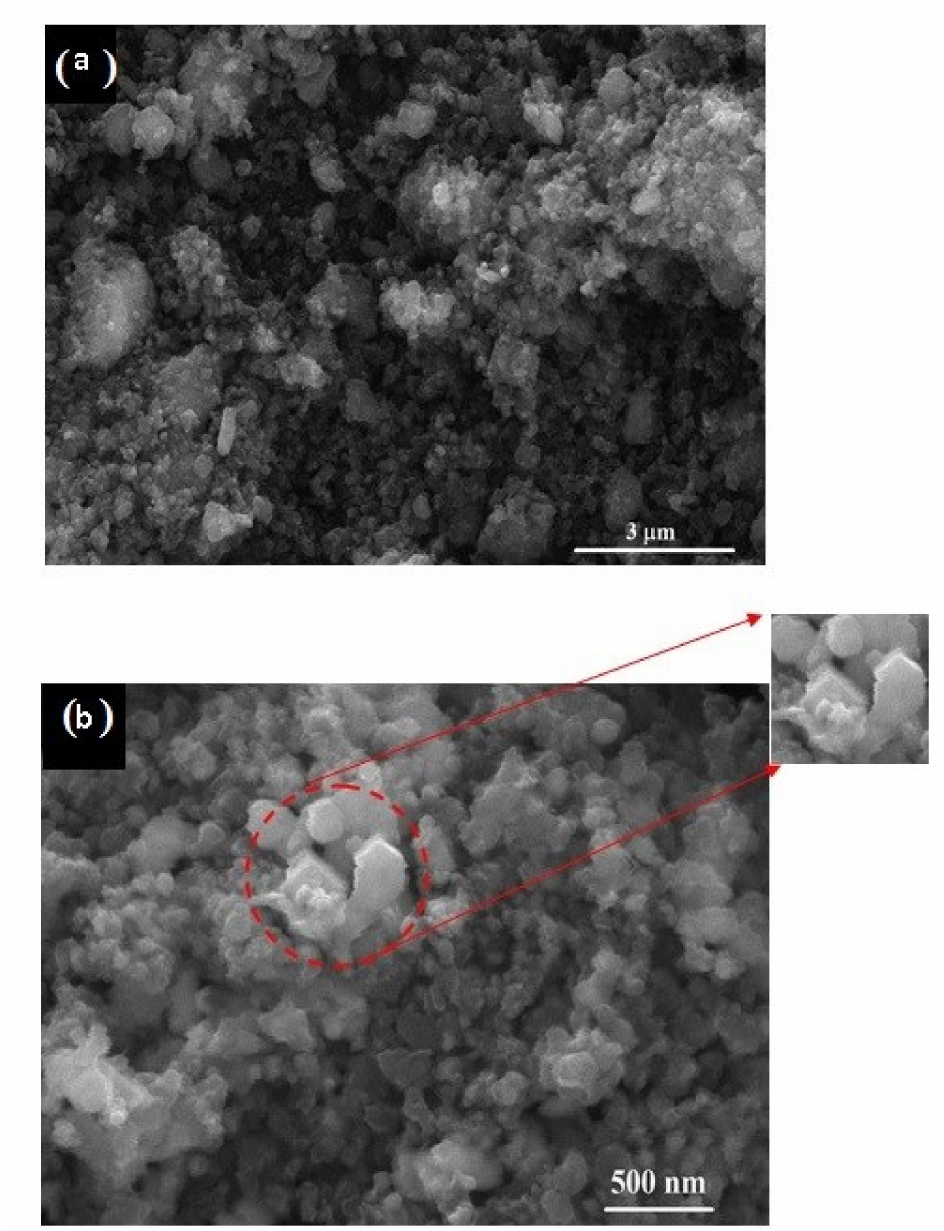
Figure 6. SEM micrograph of 15 h milled V 2 O 5 -C mixture ( a ) and its reduction product at 1050 ◦ C for 1 h ( b